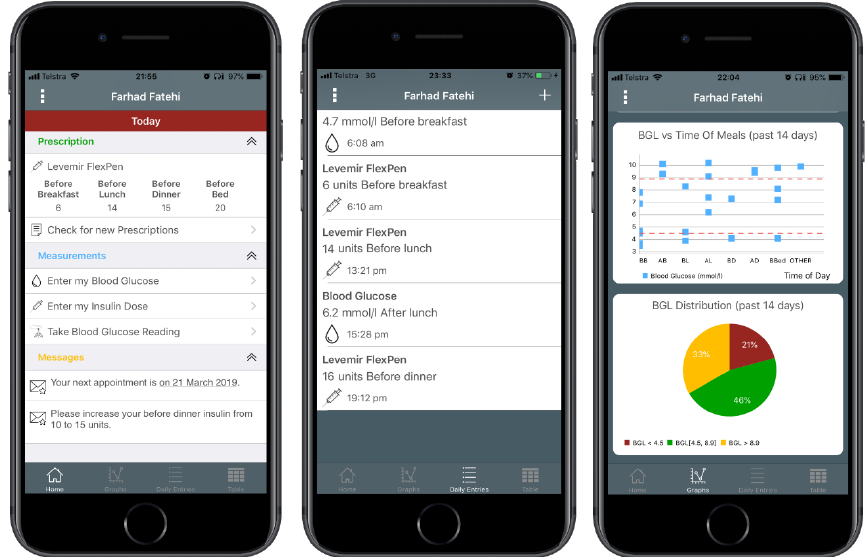
Figure 1. Screenshots of Mobile App iOS version. The app interface screenshot on the left depicts current insulin dosages and an option of downloading the latest changes made by the healthcare provider (HCP). Messages sent by the HCP are shown on the bottom. The middle screenshot displays insulin and blood glucose record whereas the right side shows the various graphical formats for easy visualisation of blood glucose